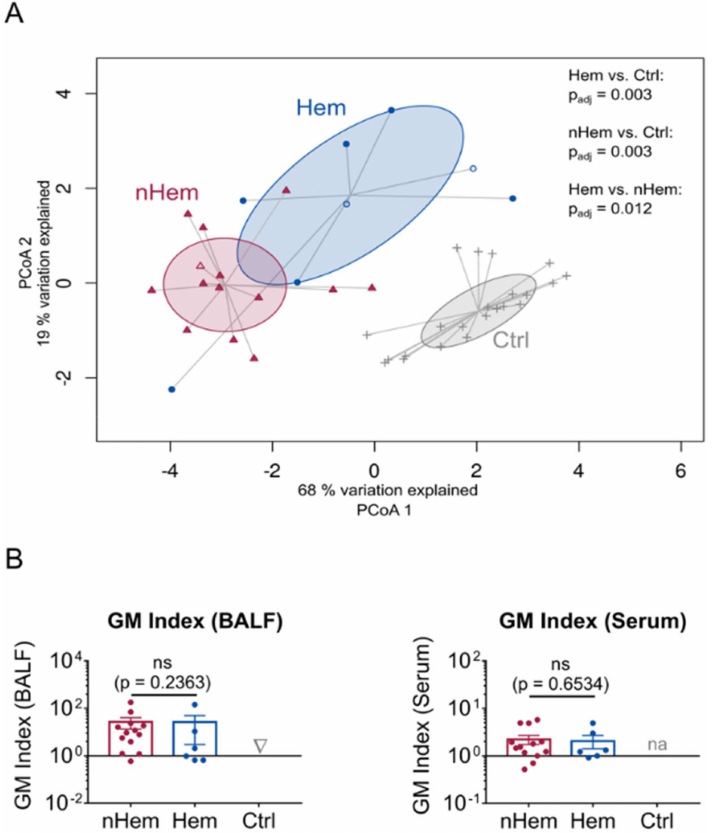
Figure 3. Comparison of tested biomarkers in the subgroup of nHem and Hem patients. ( A ) PCoA including CRP, WBC, GM in BALF, IL-8, IL-1 β , LBP, BPI and MPO. Filled red symbols indicate nHem patients ( n = 13), filled blue symbols Hem patients ( n = 6) and grey symbols patients of the control group (Ctrl; n = 19). Patients not meeting inclusion criteria, because serum GM was beneath the cut-o ff point despite typical radiological findings, are marked as non-filled symbols ( n = 3). Di ff erences between subgroups were analyzed by permutational multivariate analysis of variance. P -values adjusted for multiple testing by the Bonferroni correction method are indicated (p adj). ( B ) GM in BALF and serum are compared between nHem ( n = 13), Hem patients ( n = 6) and control group ( n = 19). Data are presented as mean ± SEM and p -values were determined by Mann-Whitney U test, non-significant (ns) results are marked. GM of serum in the control group was not analyzed